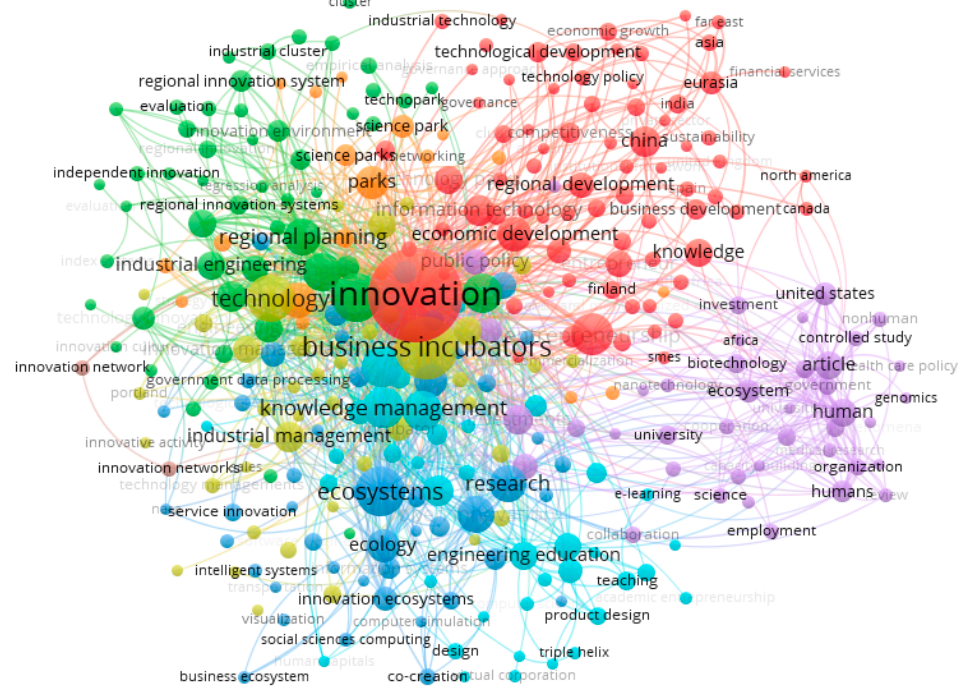
Figure 5. Cluster map